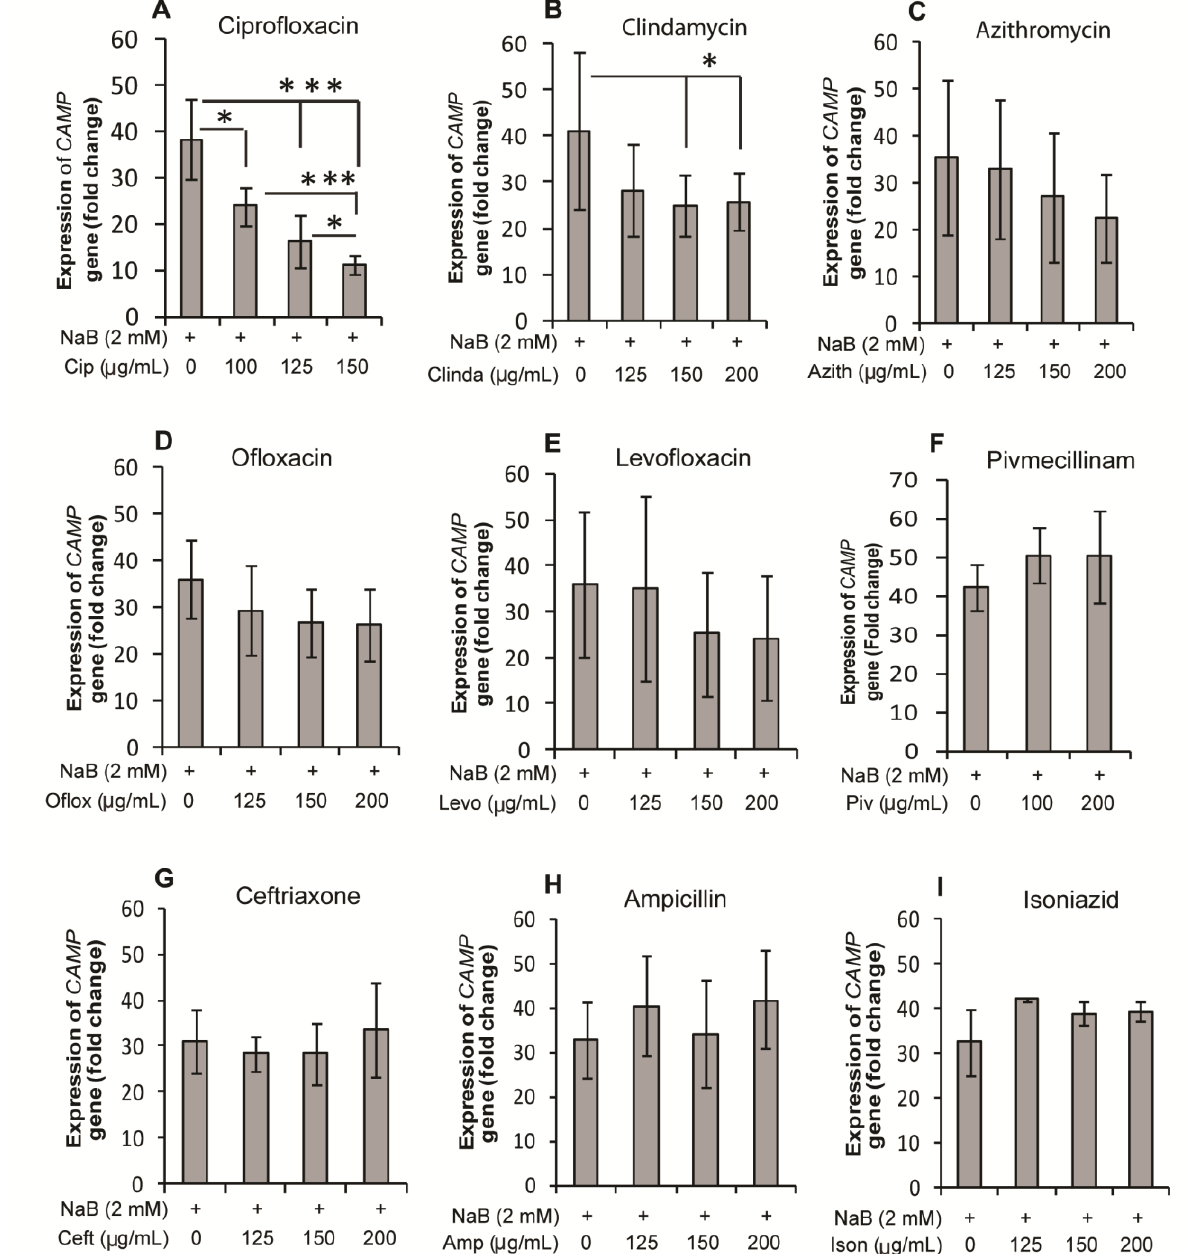
Figure 1. Effect of antibiotics on NaB-induced expression of the CAMP gene encoding LL-37 in HT-29 cells. HT-29 cells were stimulated for 24 h with 2 mM NaB alone or in combination with different concentrations of ( A ) ciprofloxacin; ( B ) clindamycin; ( C ) azithromycin; ( D ) ofloxacin; ( E ) levofloxacin; ( F ) pivmecillinam; ( G ) ceftriaxone; ( H ) ampicillin; and ( I ) isoniazid. RNA was extracted from cells and cDNA prepared, which was used to quantify CAMP gene (LL-37 transcript) expression by real time qPCR. CAMP expression is presented as fold change to control (untreated) cells. Data are given as mean ± SD of seven replicates. One way ANOVA of original data in case of clindamycin or log- transformed data for other antibiotics was utilized in comparing between different groups. Pair-wise effects between groups were compared by the Holm-Sidak post hoc comparison procedure. * p < 0.05, *** p < 0.001. NaB: sodium